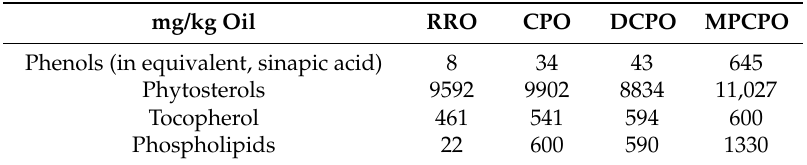
Table 1. Endogenous micronutrients in different rapeseed